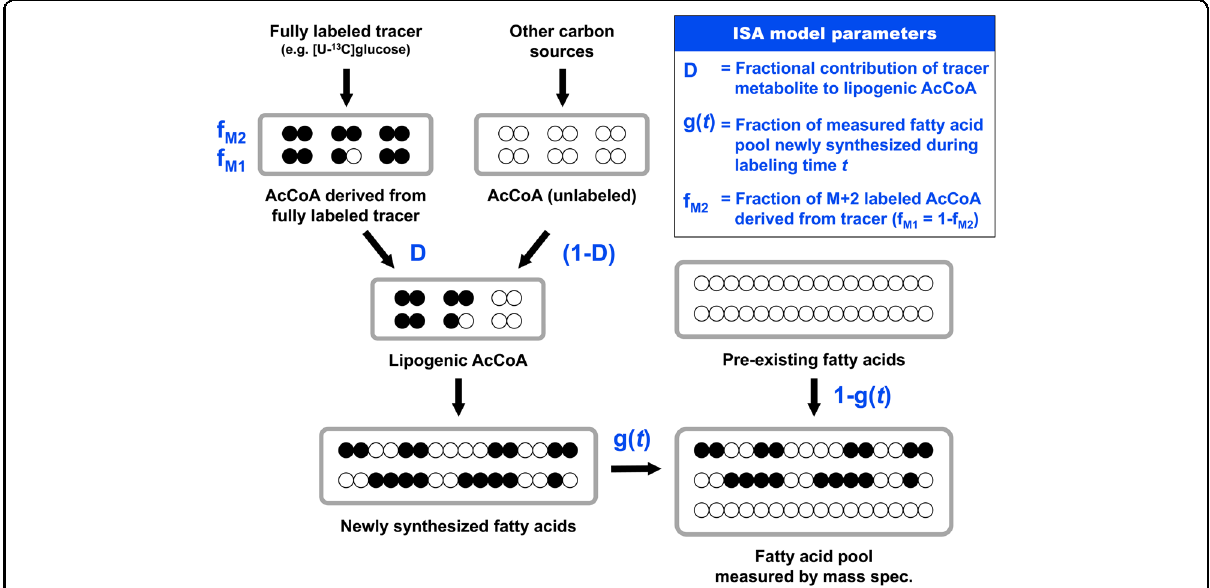
Fig. 5 The isotopomer spectral analysis (ISA) approach is used to quantify de novo fatty acid biosynthesis based on tracer experiments with fully 13 C-labeled substrates. In the classical ISA formulation, two model parameters are determined, the D -value and the g ( t )-value. The ISA approach can be generalized and extended to include additional model parameters such as f